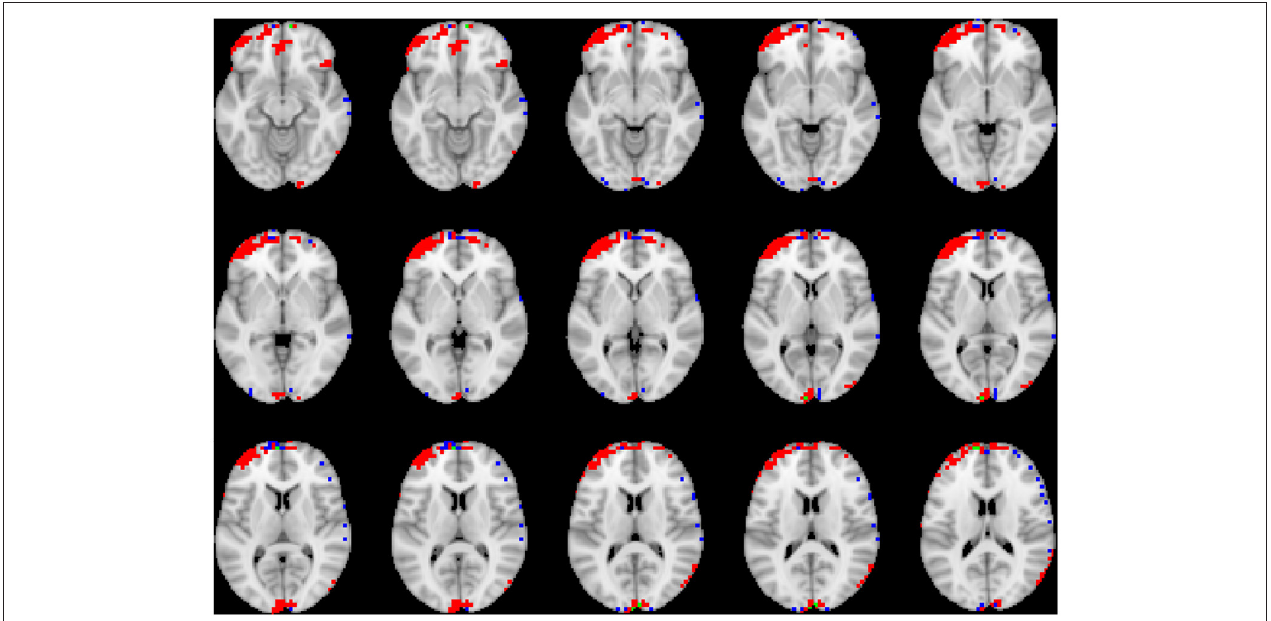
FIGURE 6 | Axial views of voxels primarily contributing to children classification in rs-fMRI image. Green, common to DBD and TD groups; red, DBD group; blue, TD group. The right side of each image corresponds with the right side of the